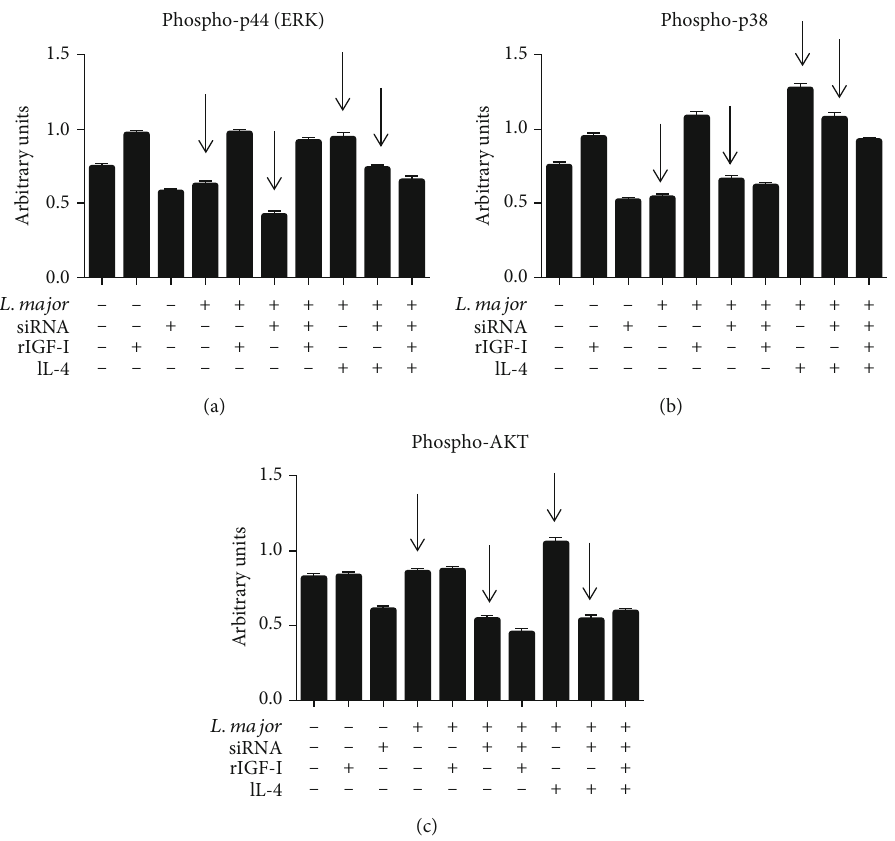
Figure 6: The e ff ects of IGF-I siRNA and IL-4 on components of the IGF-I signaling pathways: levels of phosphorylated p44 (ERK), p38 (MAPK), and AKT proteins. L. major promastigote-infected or noninfected RAW 264.7 cells transfected with or without IGF-I siRNA were stimulated for 30 minutes with IL-4 (2 ng/mL; R&D Systems, EUA) and recombinant IGF-I (50 ng/mL; R&D Systems, EUA). Cells were lysed, the proteins were separated in 10% SDS-PAGE, and subsequently, a Western blotting was performed using anti-phospho-p44 (137F5, Cell Signaling Technology, USA), anti-phospho-p38 (D13E1, Cell Signaling Technology, USA), and anti-phospho-AKT (Ser473, Cell Signaling Technology, USA) antibodies. Protein bands corresponding to protein expression levels were submitted to a densitometric analysis (AlphaEaseFC ™ software 3.2 beta version; Alpha Innotech Corporation, USA), and data are expressed in arbitrary units (adapted from Reis et al.